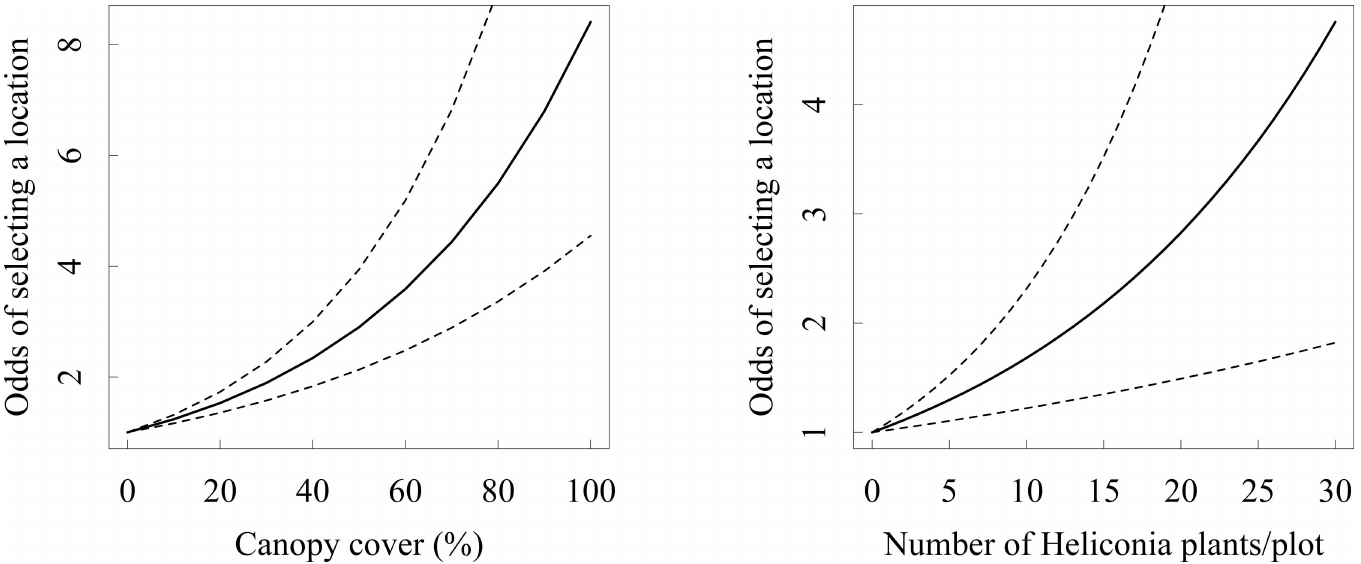
Fig 1. Effect of canopy cover (A) and number of Heliconiaplants (B) on the odds of the green hermit hummingbird choosinga given location,as calculated from the